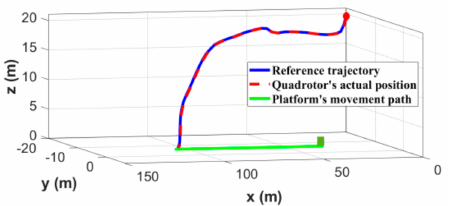
Figure 19. 3D landing trajectory during the experiment.